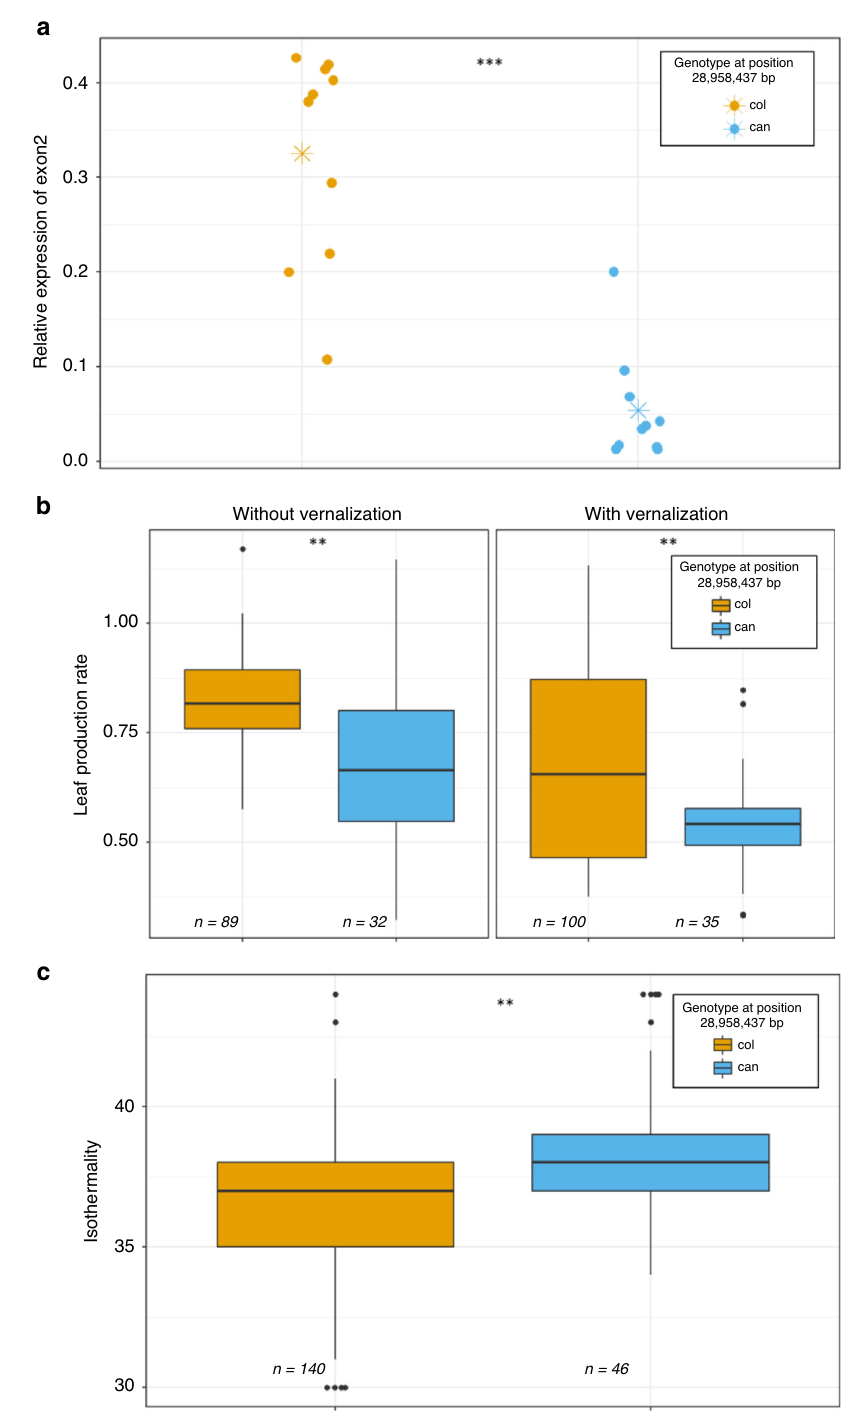
Fig. 5 The variant at position 28,958,437bp in Can-0 modulates FLM function and may play a role in adaptation. a Accumulation of exon2-containing isoforms (typical of FLM- β ) measured by qRT-PCR using the primer pair qFLM-F3 + qFLM-R3b (see Fig. 2) in nine Arabidopsis strains from the Iberian Peninsula (IP) carrying either the Can (blue) or the Col (brown) genotype at position 28,958,437 bp. Each data point represents one IP strain. The asterisks are the mean expression of each variant. b Boxplots represent leaf production rate with or without vernalization in Iberian Peninsula strains categorized according to their genotype at position 28,958,437 bp. The data were obtained from a previous publication 42 and are gathered in Supplementary Data 3. Signi fi cance of the differences was calculated according to a mixed-effect model using the genotype as a random factor and the kinship matrix as covariates (see Supplementary Table 1). c Boxplots represent isothermality in IP strains categorized according to their genotype at position 28,958,437 bp. Isothermality is calculated as follows: mean of monthly (max temp − min temp)/(max temperature of warmest month − min temperature of coldest month) × 100, and was obtained from http://www.worldclim.org/ and are gathered in Supplementary Data 3. Signi fi cance of the differences was calculated according to a mixed-effect model using the genotype as a random factor and the kinship matrix as covariates (see Supplementary Table 1). Source data underlying Fig. 5a are provided as a Source Data fi